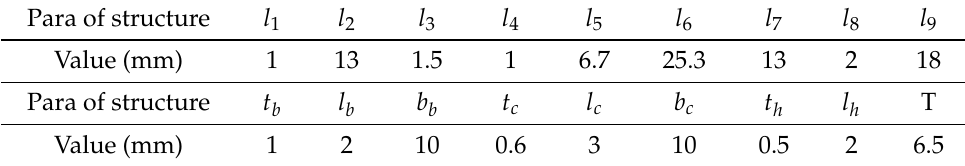
Table 4. Main parameters of the HBLB